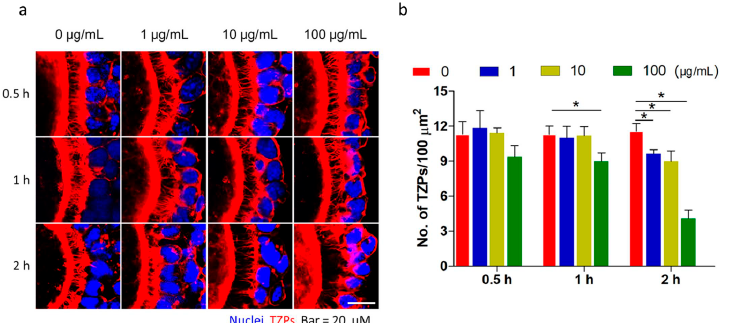
Figure 1. Fullerenol accelerates transzonal projection (TZP) retraction. Freshly isolated oocyte-granulosa cell complexes (OGCs) were cultured in medium with different concentrations of fullerenol (0, 1, 10, and 100 μ g/mL) for different times (0.5, 1, and 2 h). TZP number and integrity were evaluated using fluorescent labeling. ( a ) Representative images of the F-actin-rich TZPs between oocyte and surrounding granulosa cells are shown (red, scale bar: 20 μ m). Blue color indicates granulosa cell nuclei; ( b ) Intact TZPs were counted and expressed as mean ± SEM ( n = 5–6). Experiment was performed three times, * p < 0.05.